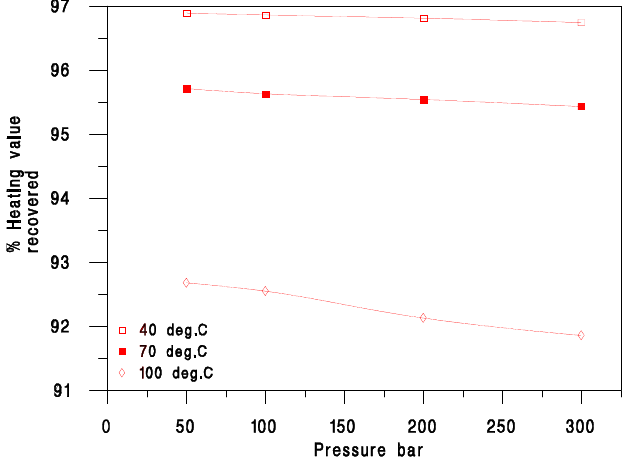
Figure 9. Effect of air pressure on heating value recovery of Silverdale coal.